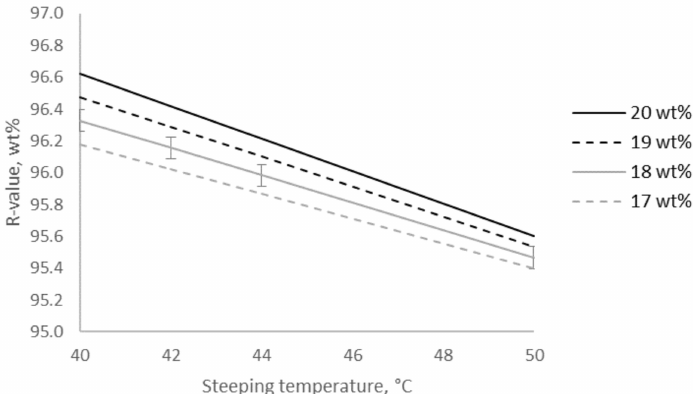
Figure 1. Modeled residue after extraction of hardwood kraft dissolving pulp with aqueous NaOH at di ff erent concentrations and temperatures, expressed as R-value, and its RMSE (root mean square